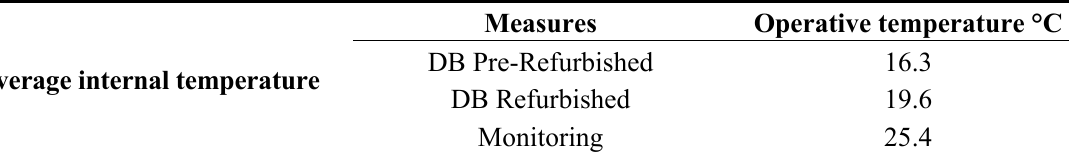
Table 7. Average internal temperature of living room during the heating season—Liverpool current weather data.